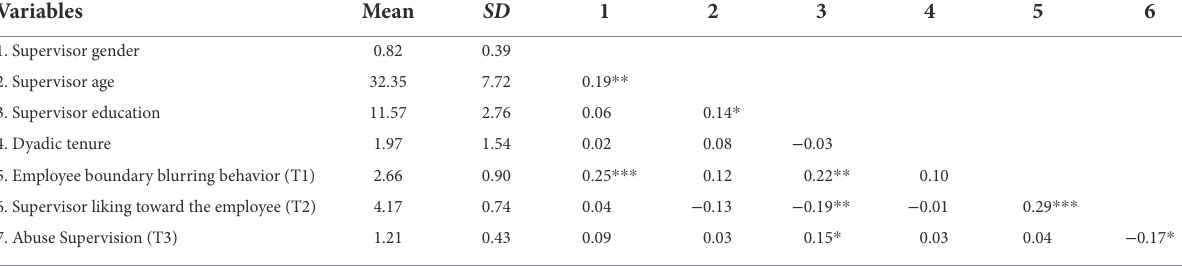
TABLE 3 Descriptive statistics and correlation coefficients of variables in Study 2.